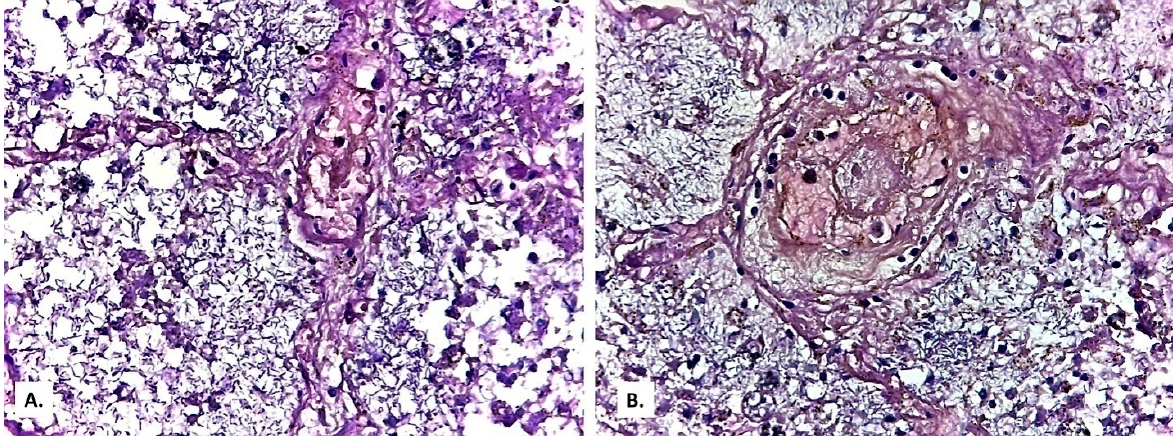
Figure 10. ( A , B ) Cystic forms positive by Giemsa stain, ( C ) Grocott-Gomori’s methenamine silver stain, and ( D ) PAS stain (black arrows—full cystic forms; white arrow—empty cystic form).